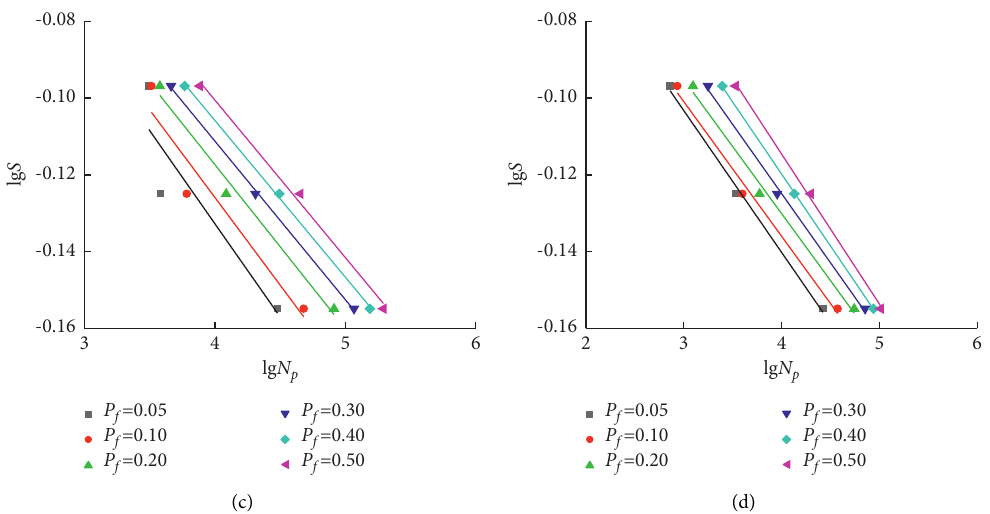
Figure 13: lg S –lgN relationships of AASC with various degrees of frost damage for various failure probabilities. (a) n � 0. (b) n � 50. (c) p n � 100. (d) n � 150.